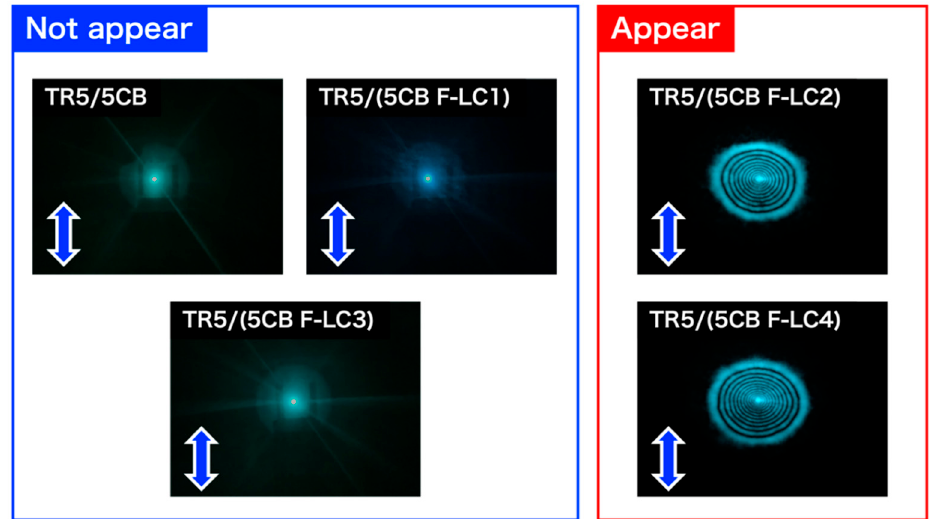
Figure 7. Typical diffraction patterns of all samples induced by a multi-mode laser beam formed at 18 W/cm 2 . Blue arrows indicate the polarization direction of the incident light.